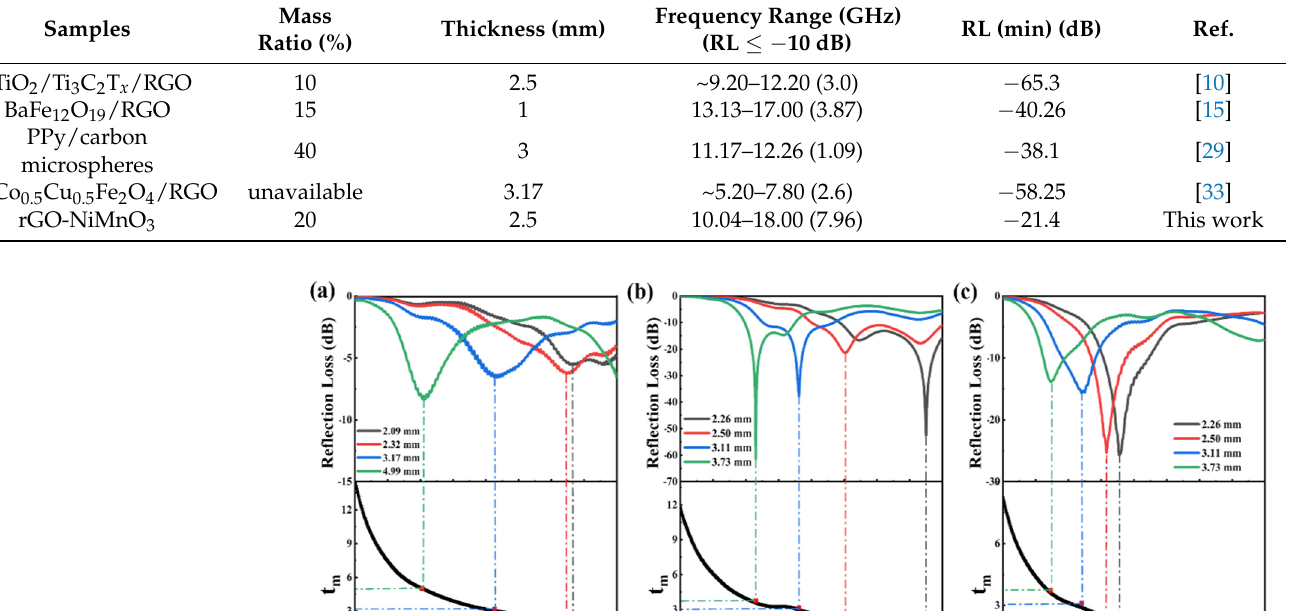
wave absorption; Figure S2. Attenuation constant (a) and impedance matching ratio (b) of rGO and MnO 2 ; Figure S3: Comparison of various absorber thickness ( t m ) for (a) MnO 2 -20 wt% and (b)